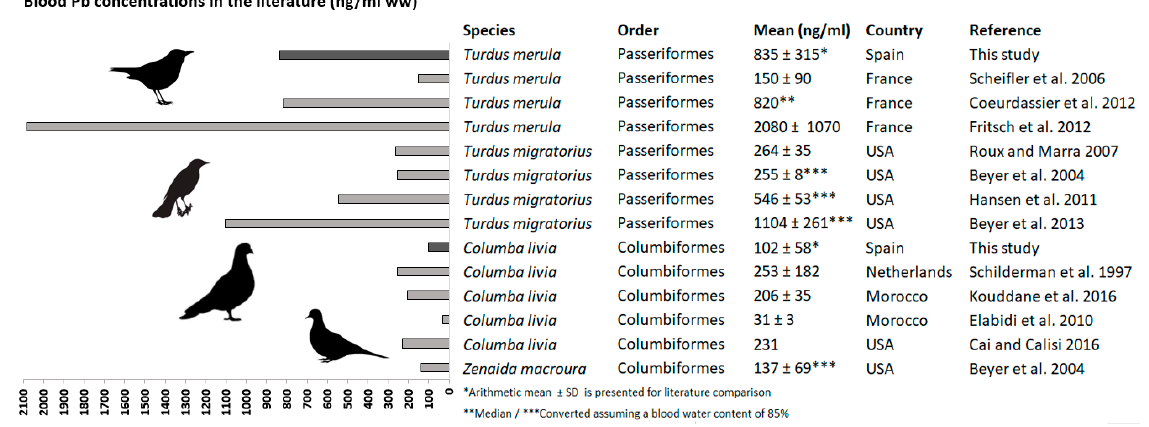
Figure 3. Blood Pb concentrations (ng/mL, w.w.) reported in Passeriformes and Columbiformes inhabiting polluted envi- Figure 3. BloodPbconcentrations(ng/mL,w.w.) ronments.